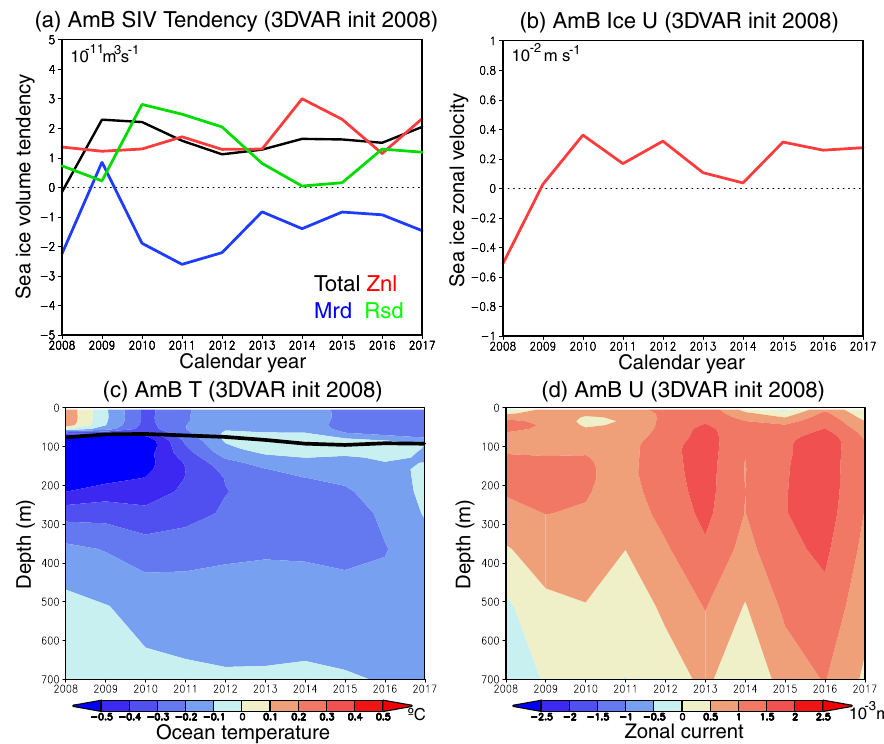
Fig. 5 Atmospheric circulation and temperature anomalies during a high sea ice period (2008 – 2017). a Time series of sea ice volume (SIV) tendency anomalies (Total; black in 10 − 11 m 3 s − 1 ) and its zonal (Znl; red), meridional (Mrd; blue) and residual (Rsd; green) components (see Eq. (1) in Methods) averaged in the Amundsen – Bellingshausen Sea (AmB; 120° − 60°W, 70° − 60°S) in the 3DVAR experiment predicted from March 1st 2008. We calculated the anomalies with respect to the period of 1982 – 2018. b Same as in a , but for sea ice zonal velocity (Ice U; in 10 − 2 m s − 1 ) anomalies in the AmB region. c Time series of the upper 700-m ocean temperature (T; in °C) anomalies predicted from March 1st 2008 in the 3DVAR experiment. A black line indicates the mixed layer depth de fi ned by the depth at which the potential density increases by 0.03 kg m − 3 from the ocean surface. d Same as in c , but for the upper 700-m zonal current (U; in 10 − 2 m s − 1 ) anomalies as a function of depth. Positive values indicate anomalous eastward